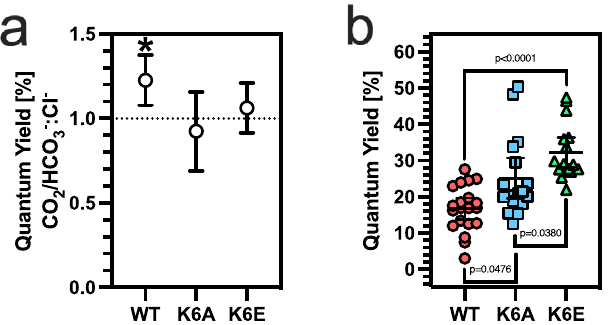
Fig. 2 | CO 2 enhances ApcAB WT ( αβ ) 3 QY in vitro. a Ratio of the measured fl uor- escence QY with 20mM CO 2 /HCO 3 − or NaCl for recombinant Synechococcus sp. PCC 7002 ApcAB WT ( αβ ) 3 , ApcAB K6A ( αβ ) 3 , or ApcAB K6E ( αβ ) 3 trimers (* p =0.0036, one sample t -test, ratio is derived from n =11 independent replicates for WT and n =7 independent replicates for K6A, mean±95% CI). b Basal fl uorescence QY for recombinant Synechococcus sp. PCC 7002 ApcAB WT ( αβ ) 3 , ApcAB K6A ( αβ ) 3 , or ApcAB K6E ( αβ ) 3 trimers(Kruskal-Wallistest, n =20,17,16independentreplicatesfor WT, K6A, and K6E respectively, mean±95% CI). Source data are provided as a Source Data fi